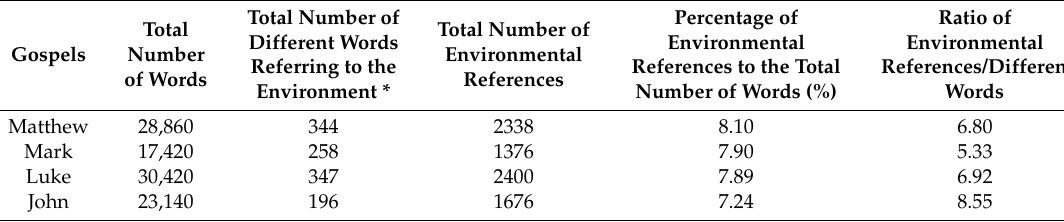
Table 1. Number of environmental references per